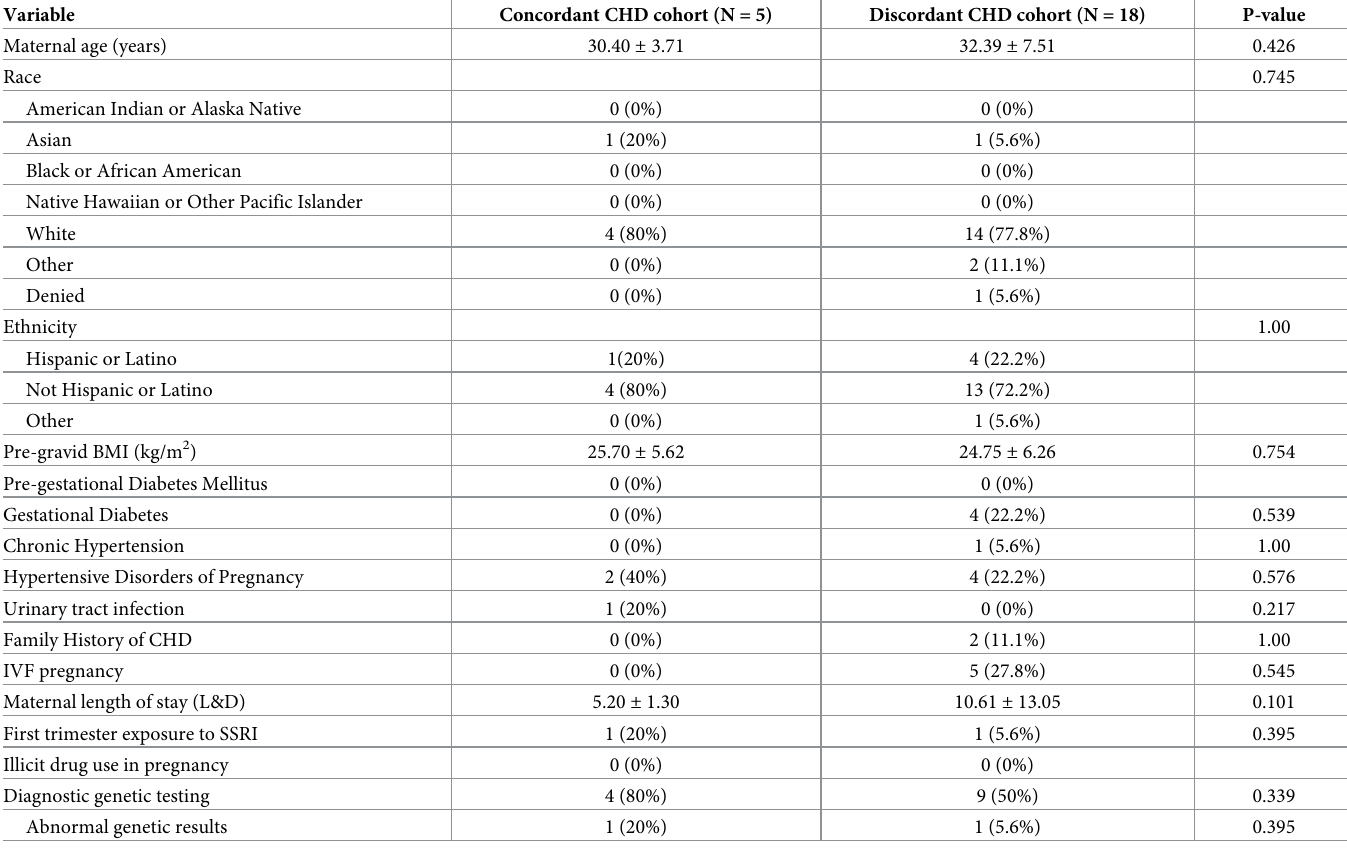
Table 2. Maternal demographics in concordant and discordant MC twins (p =